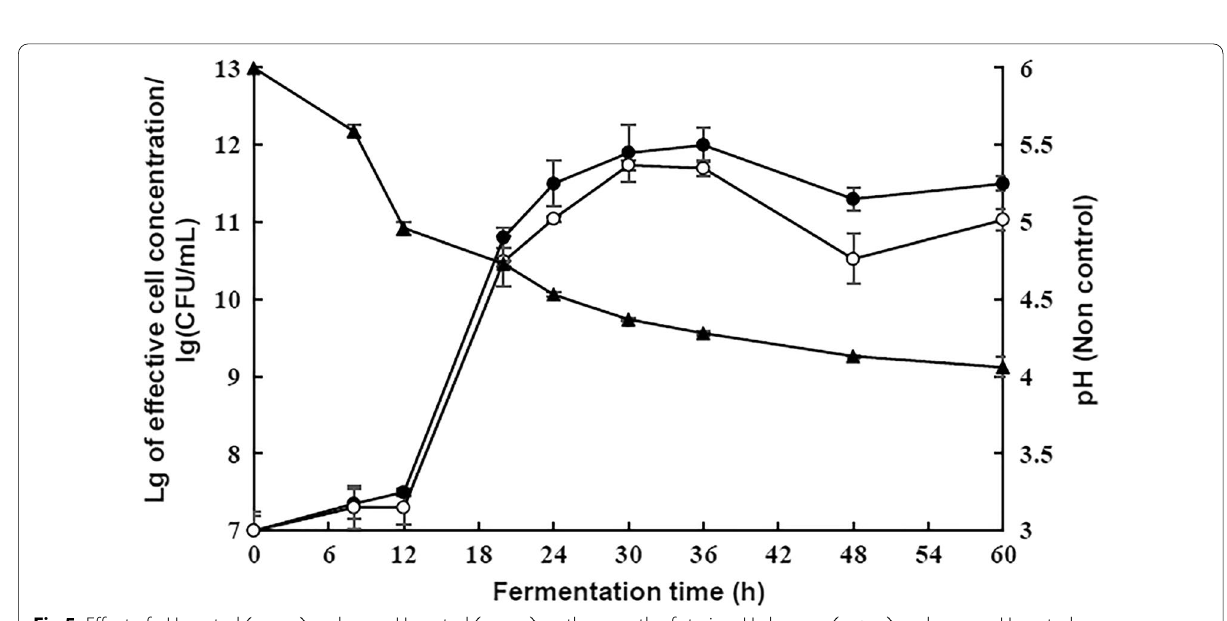
Fig 5 Effect of pH control and non-pH control on the growth of strain. pH changes under non-pH control